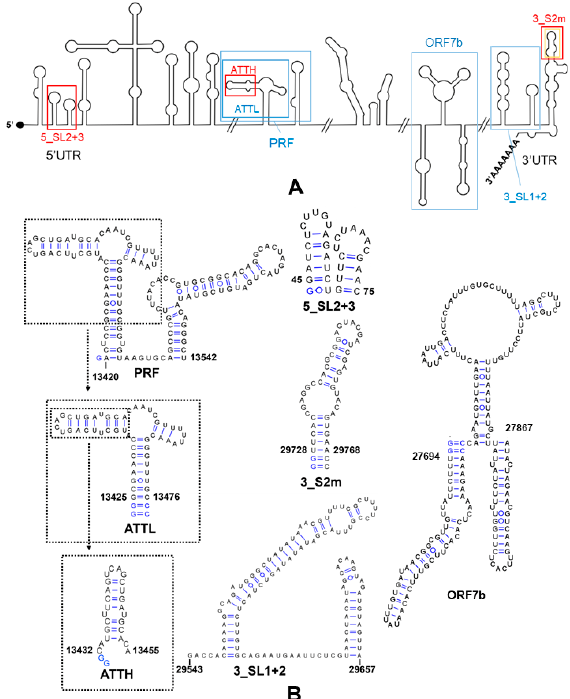
Figure 3. SCoV2 genome and viral RNA elements analyzed in this study. ( A ) Secondary structure representation of the SCoV2 genome, indicating the domains examined as possible targets for clomiphene citrate, trim, and qz2. Blue rectangles indicate secondary structure domains analyzed with ligand-based NMR experiments. Red rectangles mark domains studied with ligand-based and RNA-based NMR experiments. The orange rectangle around the 3_S2m hairpin indicates that this domain was additionally analyzed with fluorescence experiments. The small ATTH domain was investigated with RNA-based NMR experiments only. ( B ) Secondary structure of the SCoV2 RNA constructs evaluated in this report: 32-nt 5_SL2+3 domain, 124-nt full-length PRF domain, 56- nt PRF ATTL subdomain, 26-nt PRF ATTH hairpin, 176-nt ORF7b segment, 115-nt 3_SL1+2 do- main, and 45-nt 3_SL2m stem–loop. The blue-colored nt mark changes relative to the wild-type sequence introduced to increase transcription yield. The viral nt encompassed by each domain are indicated using genomic